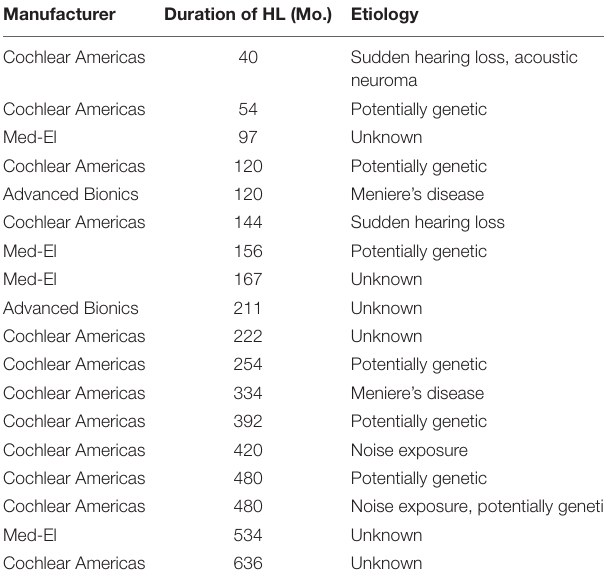
TABLE 1 | Participant cochlear implant